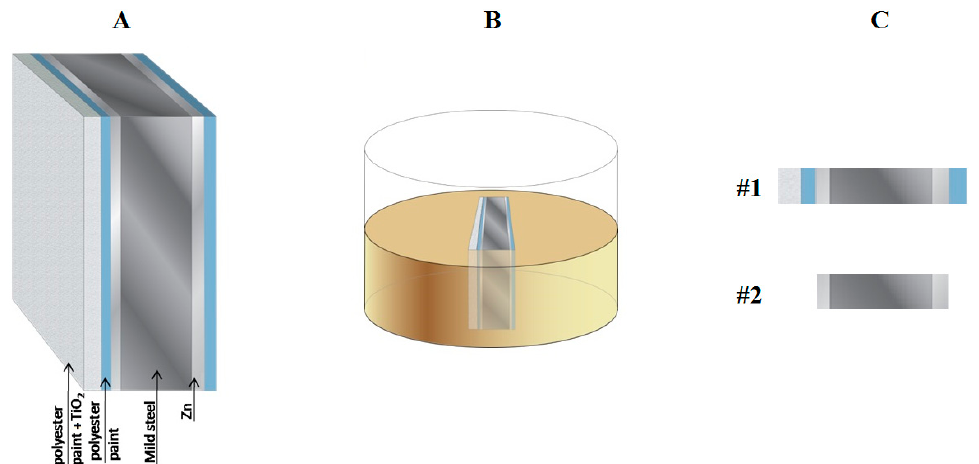
Figure 1. Sketches depicting the sample preparation process and samples characteristics: ( A ) view of the complete coil-coating cut edge system; ( B ) epoxy resin sleeve containing the complete coil-coating cut edge system; and ( C ) top view of the two different cut edge configurations resulting before and after removal of the polymer layers at either side.